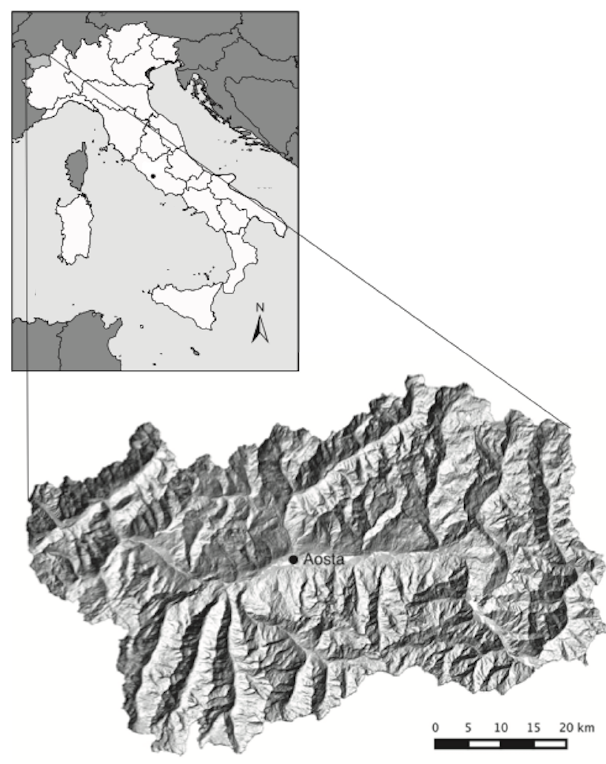
Figure 1. Map of the study area.